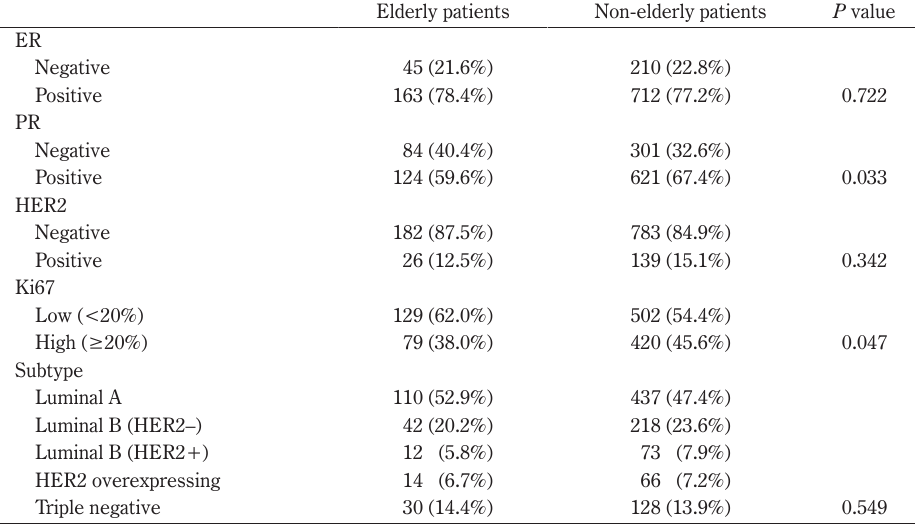
Elderly patients